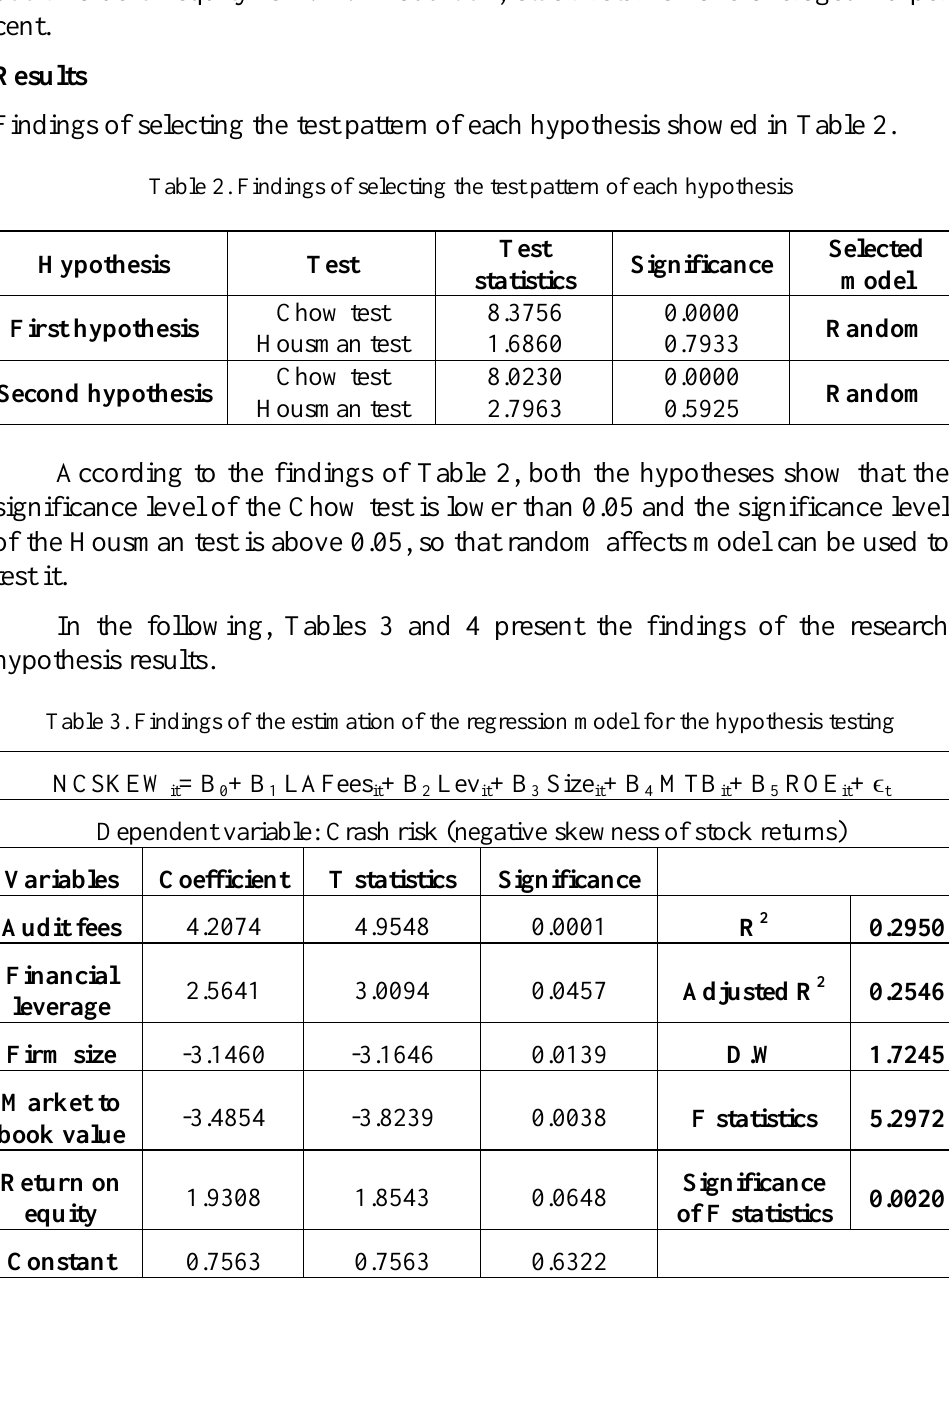
Table 2. Findings of selecting the test pattern of each hypothesis